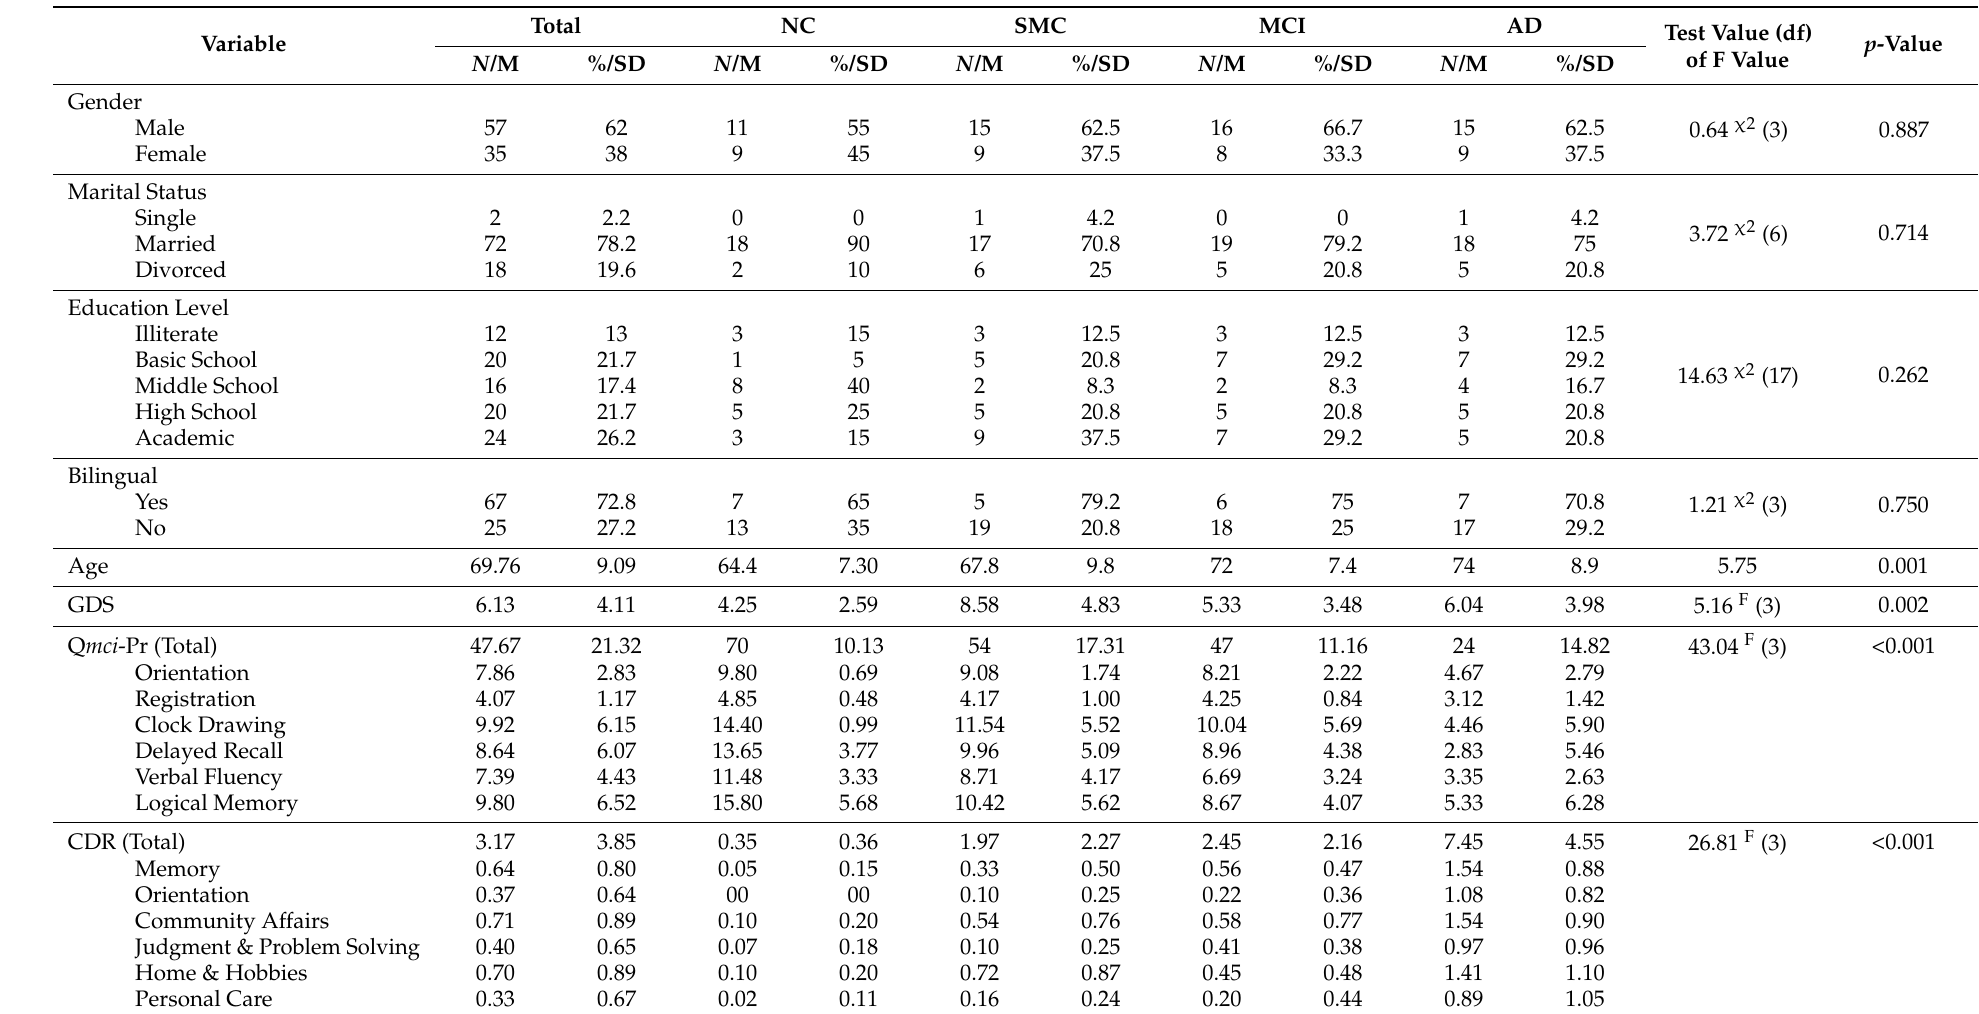
Table 1. Demographic and clinical characteristics of the study